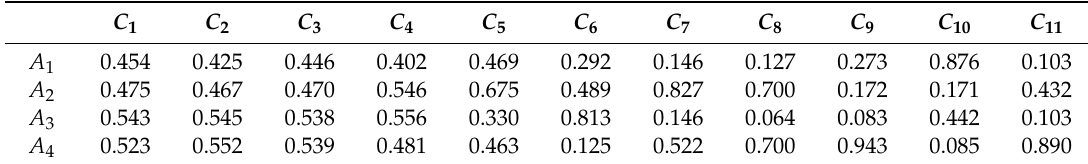
Table 10. Normalized Decision Matrix.